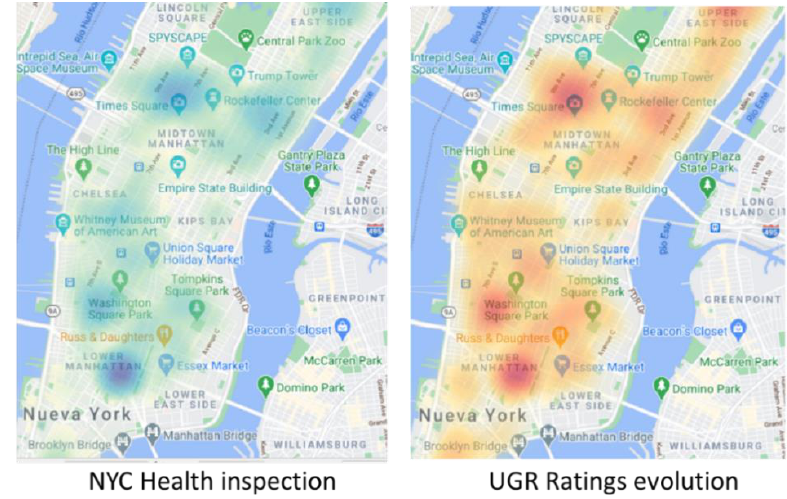
Figure 2. Visualization of the NYC health inspection and UGR ratings evolution.